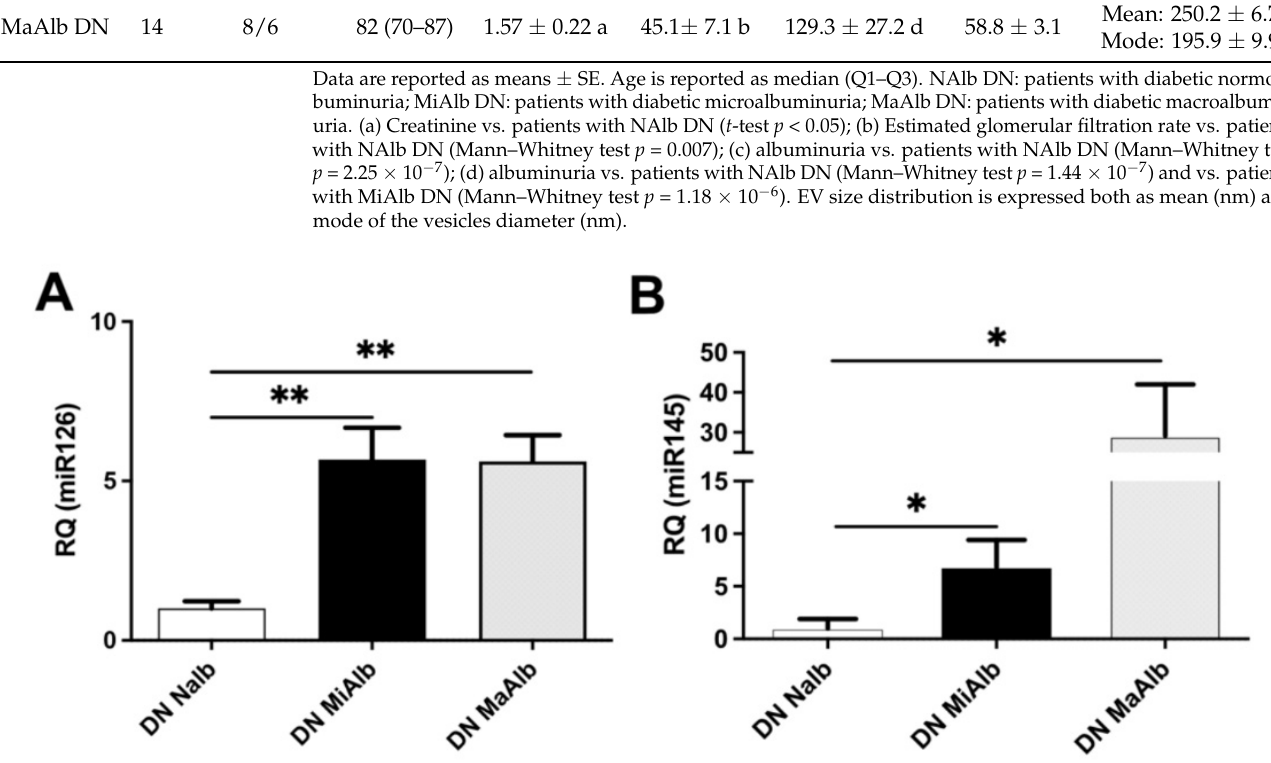
2.3. miRNA Modulation in EVs Released by Glomerular Cells in an In Vitro Diabetic Model of Nephropathy